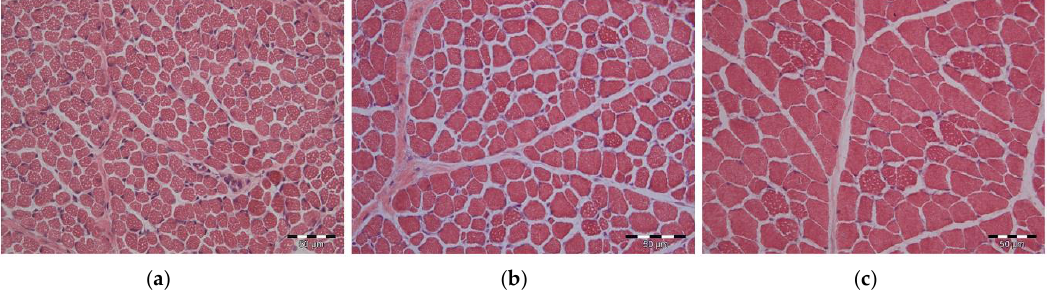
Figure 2. ( a – c ): Hematoxylin and eosin (H/E)-stained longissimus muscle cross sections of piglets at 5, 12 and 26 dpn, respectively. Nuclei appear dark blue. Scale bar = 50 µm.